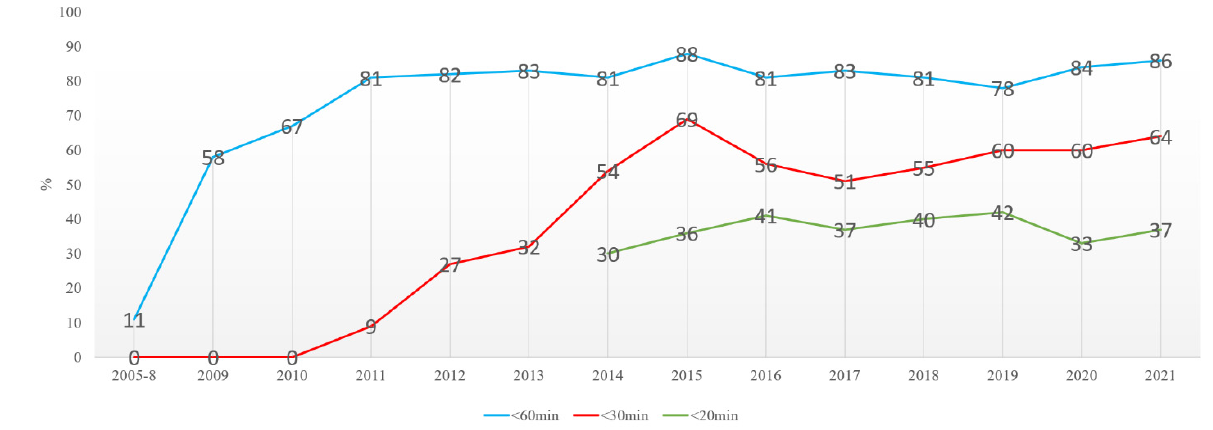
Figure 5. the number of patients thrombolysed under 20 and 30 minutes. Figure 5. The number of patients thrombolysed under 20 and 30